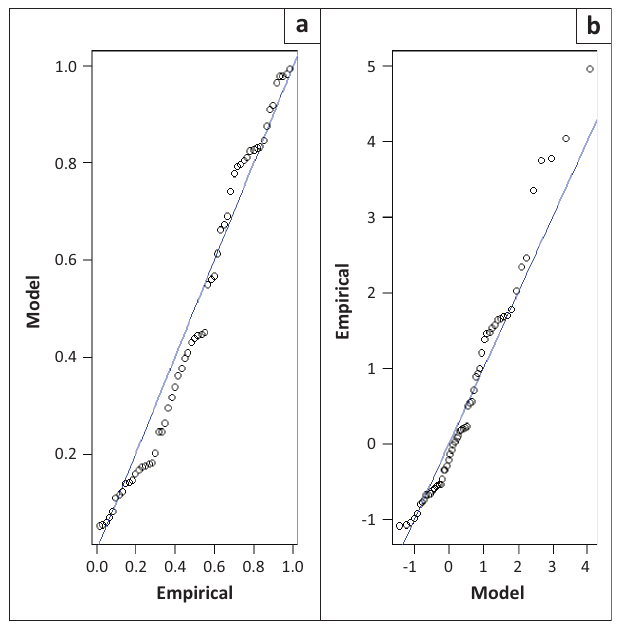
FIGURE 4: Diagnostic plots for the time-heterogeneous generalised extreme value model with a trend in the scale parameter at Sicacate hydrometric station: (a) Residual probability plot; (b) Residual quantile plot.